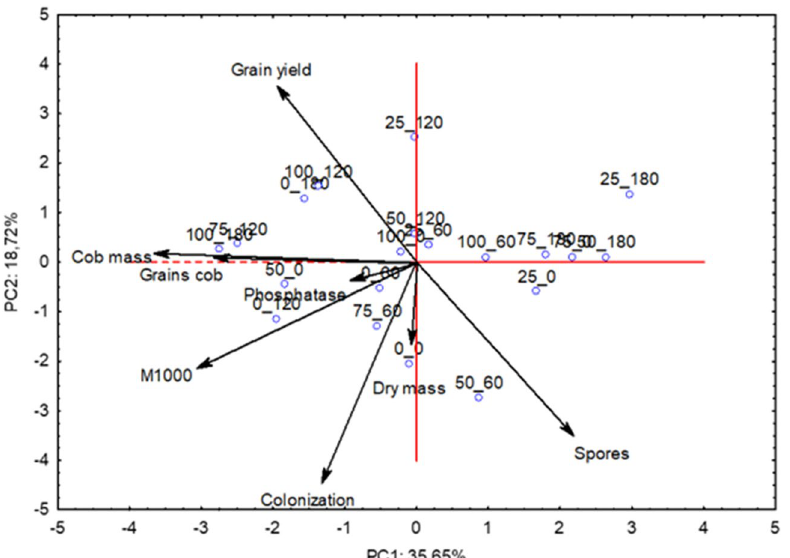
Figure 1. Biplot graph for the principal components PC1 and PC2 in the principal component analysis with amounts of P 2 O 5 and inoculant containing Rhizophagus intraradices in 2019 season. PC1 = principal component one; PC2 = principal component